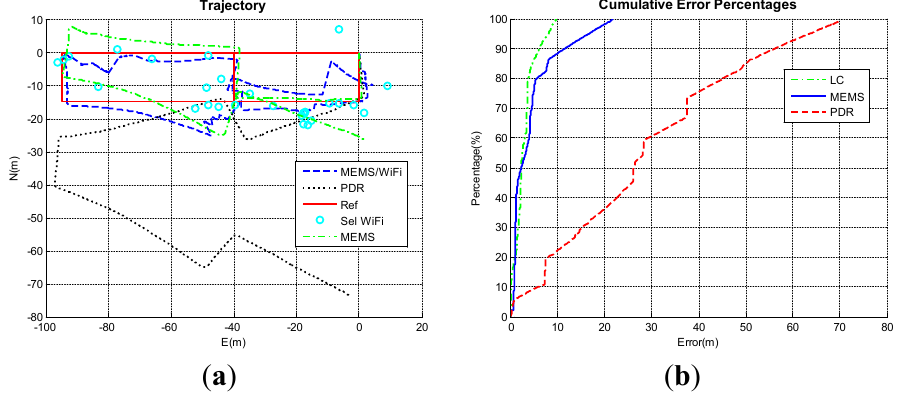
Figure 11. Navigation results of PDR, the proposed MEMS solution, and WiFi/MEMS integration (Trajectory II: Pedestrian 2, Smartphone B). ( a ) Trajectories; ( b ) Cumulative error percentages.